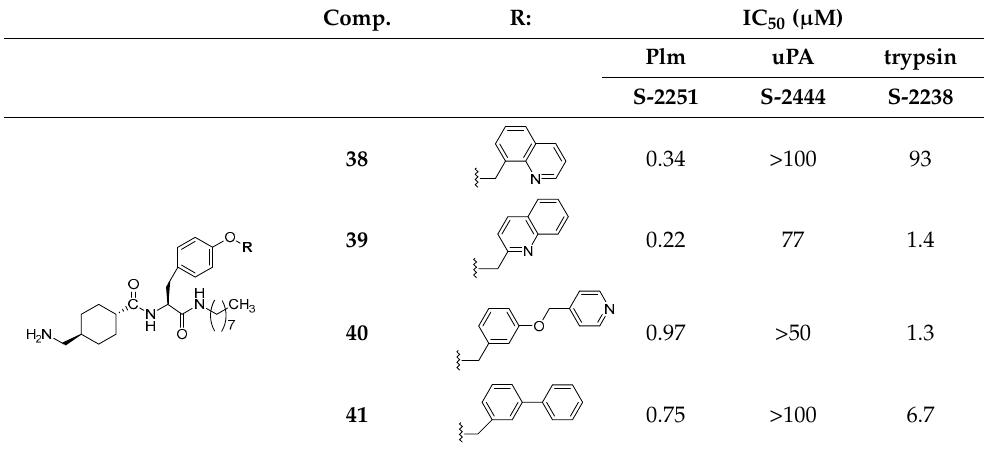
Table 9. Inhibitory activity of compounds 38–41 [33] against various proteases . Comp.